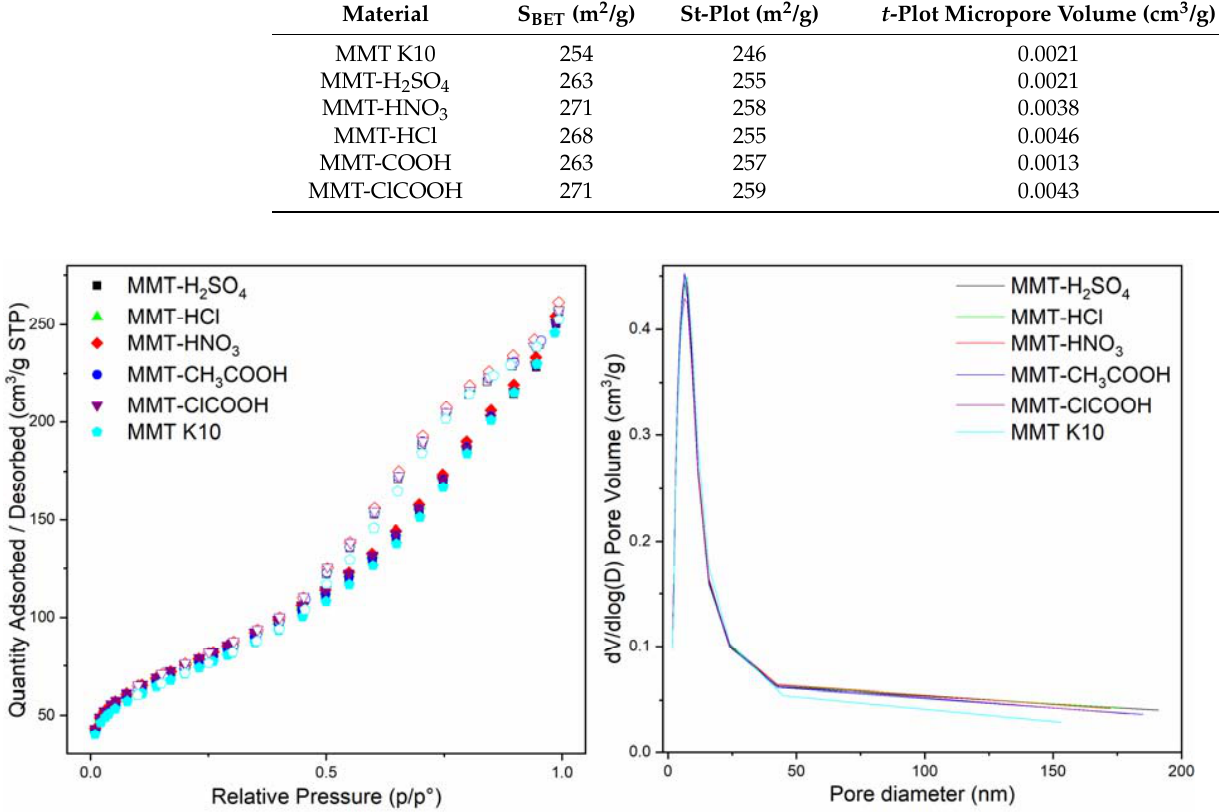
Figure 3. Absorption–desorption isotherms.